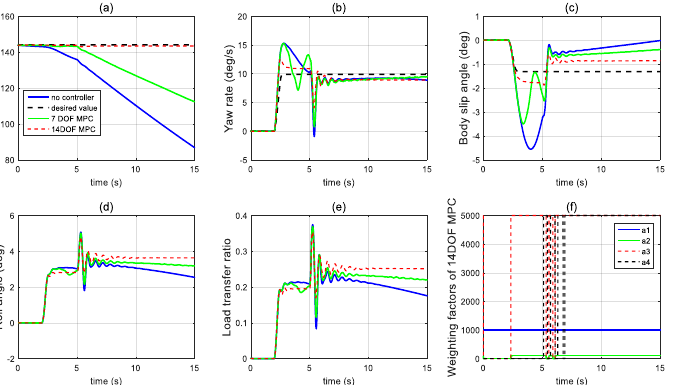
Figure 14. The changing of front-left tyre parameters after tyre blow-out in the second set of simulations ( a ) rolling re- sistance, ( b ) tyre vertical and cornering stiffness.